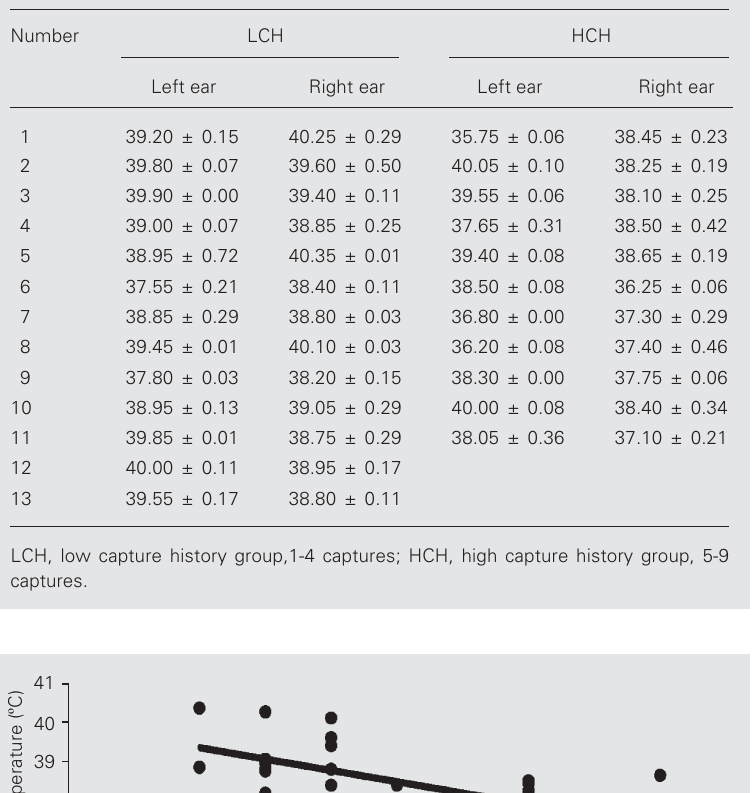
Table 1. Right and left ear tympanic temperature (mean ± SEM) of marmosets from the low capture history group (N = 13) and high capture history group (N = 11).